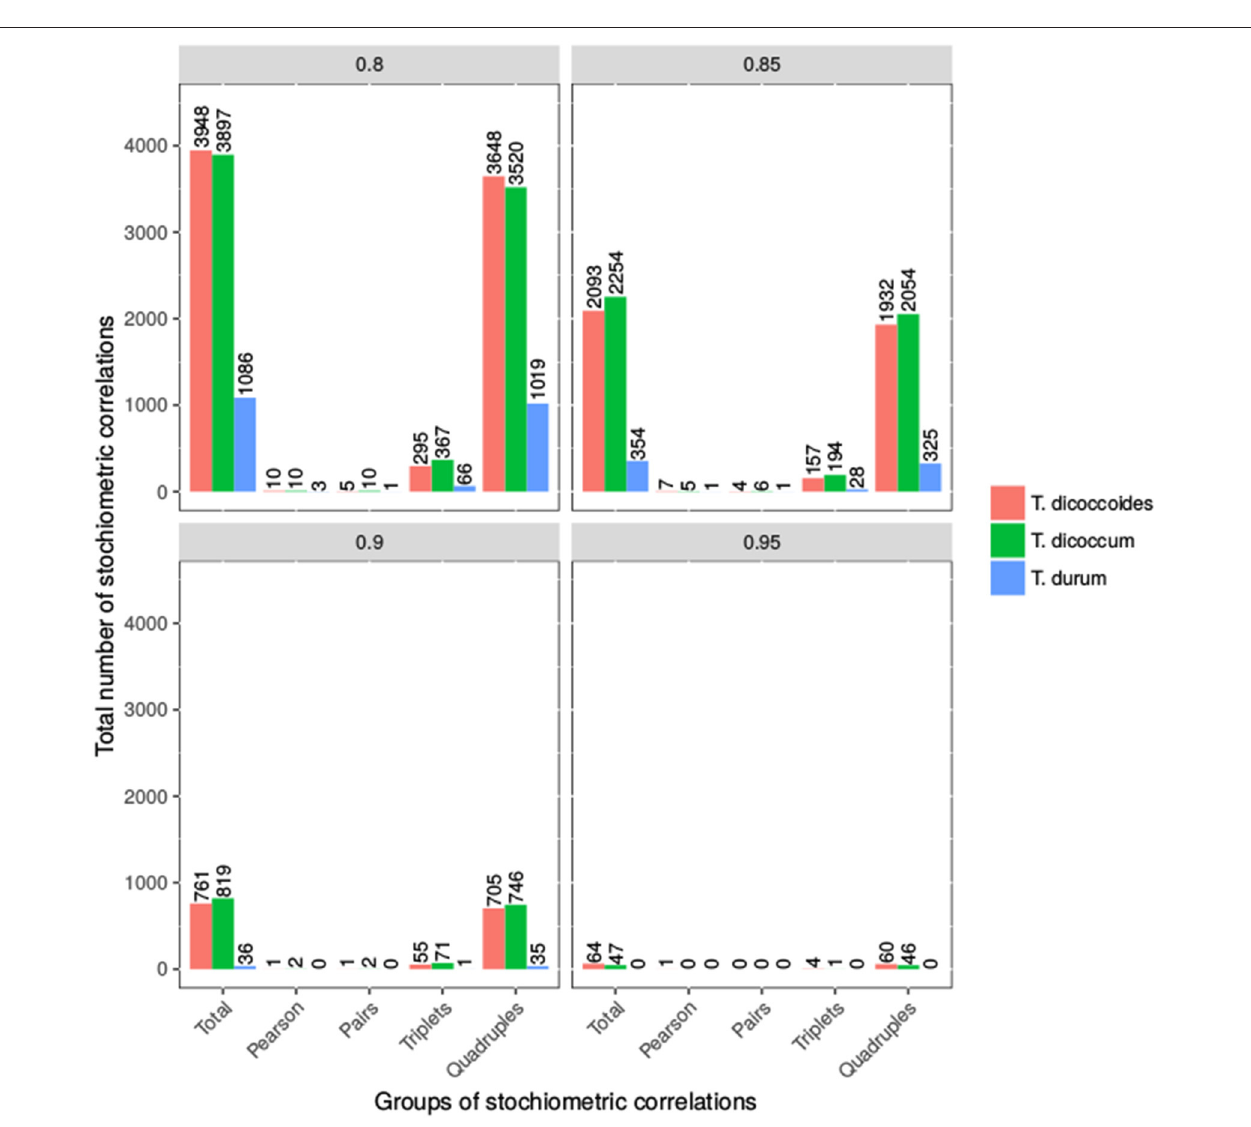
FIGURE 5 | Number of Stoichiometric Correlations of Wheat taxa. Shown is the number of stoichiometric correlations at the four thresholds 0.8, 0.85, 0.9, and 0.95. The bars represent the total number of stoichiometric correlations, pairs, triplets and quadruples for all three wheat taxa. The exact values are shown above the bars.